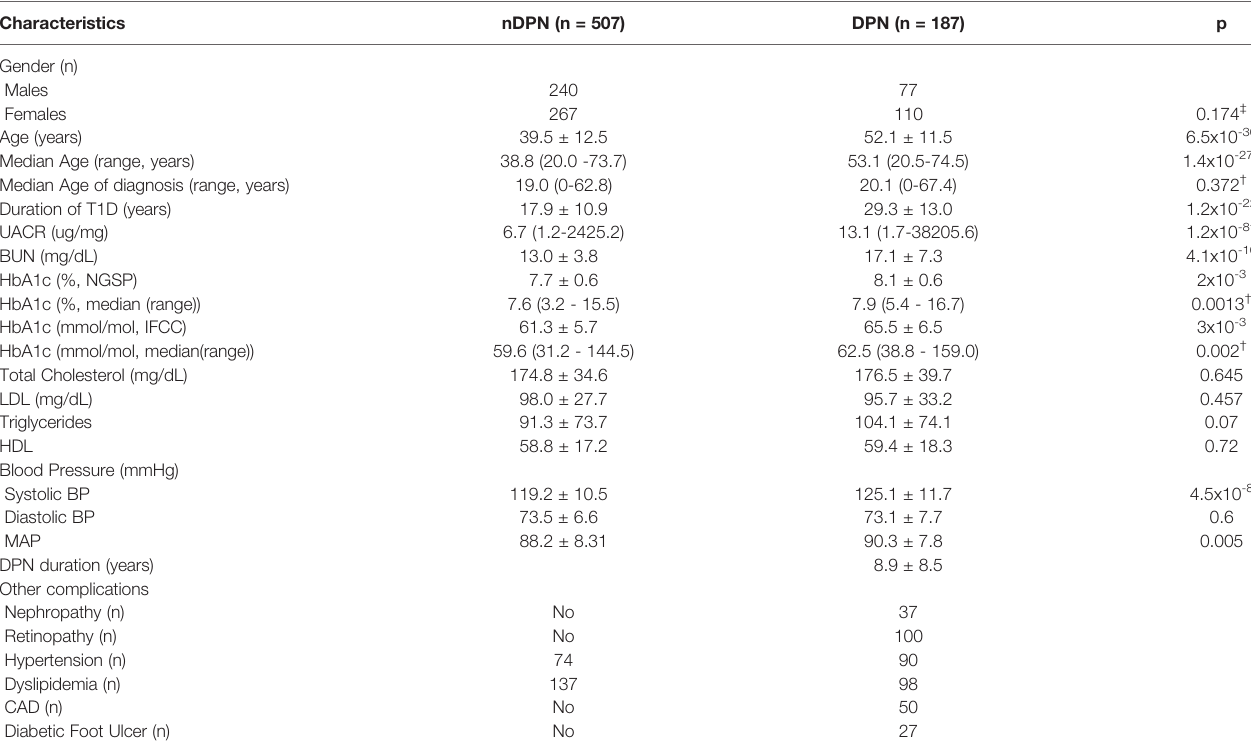
TABLE 1 | Demographic and Clinical variable for 694 Caucasian T1D patients without (nDPN) and with Peripheral Neuropathy (DPN).